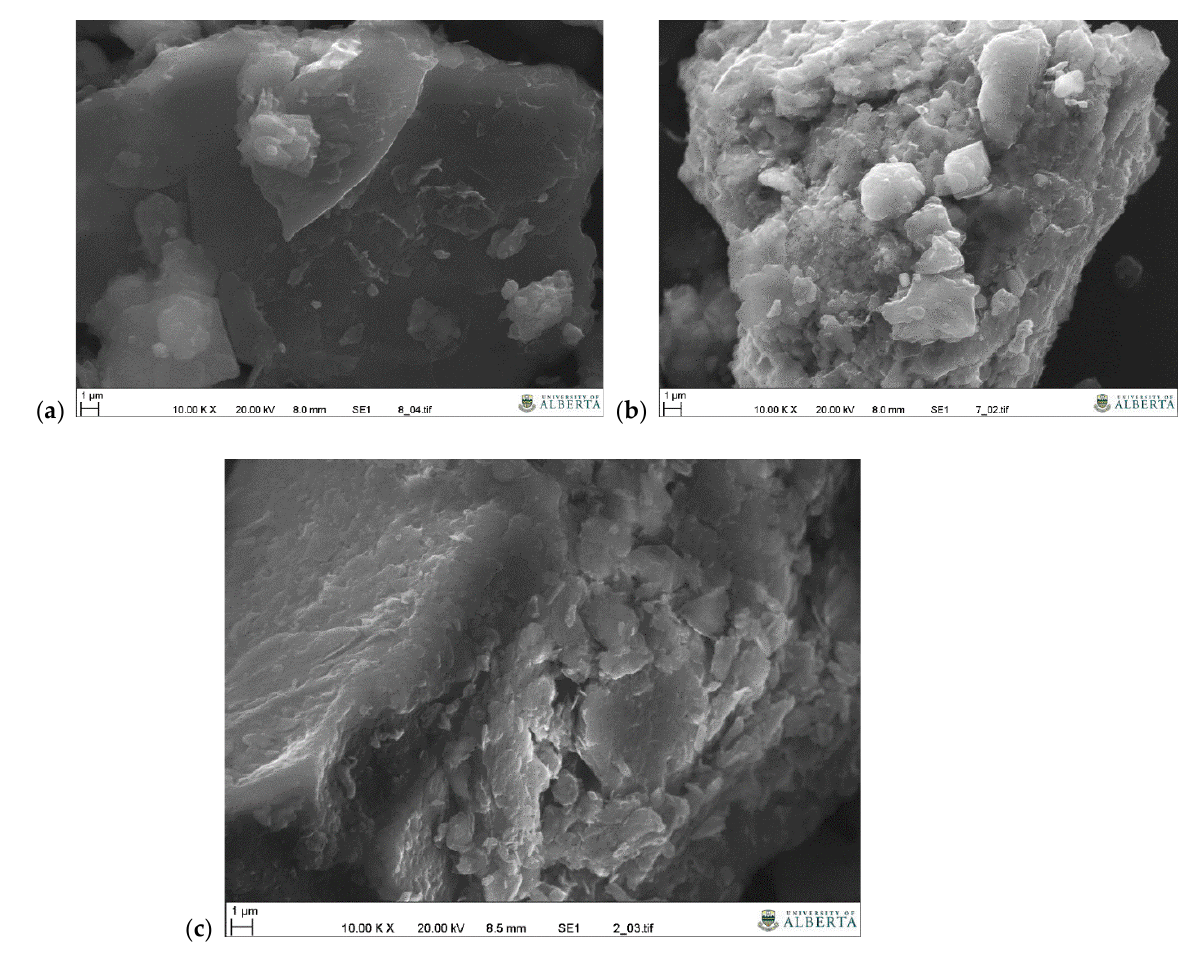
Figure 8. Surface area of particles: ( a ) control, ( b ) 30 min WAO, and ( c ) 5 min WAPO.